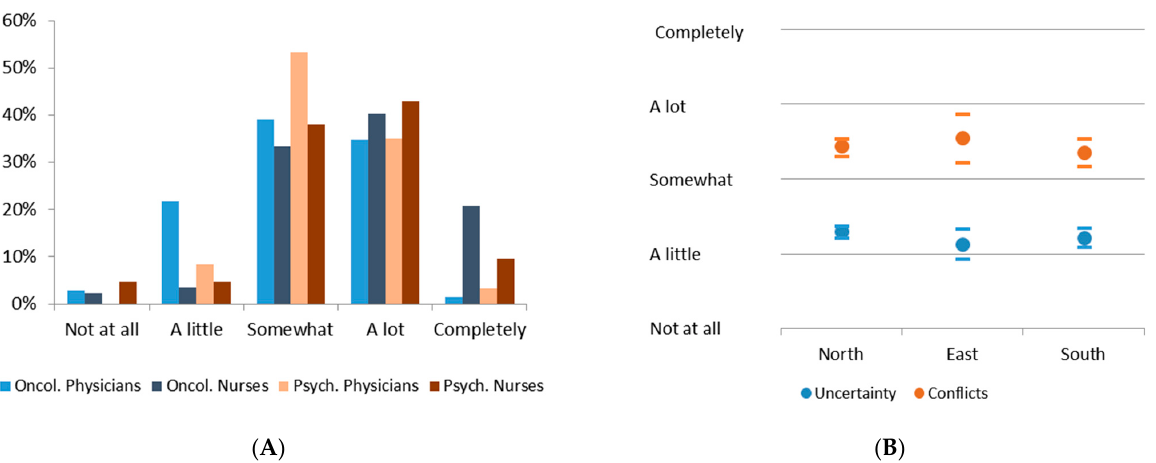
Figure 2. ( A ) Histogram of decisional conflicts within professional groups; ( B ) regional distribution of decisional uncertainty and conflicts in Germany (mean and 95% CI).